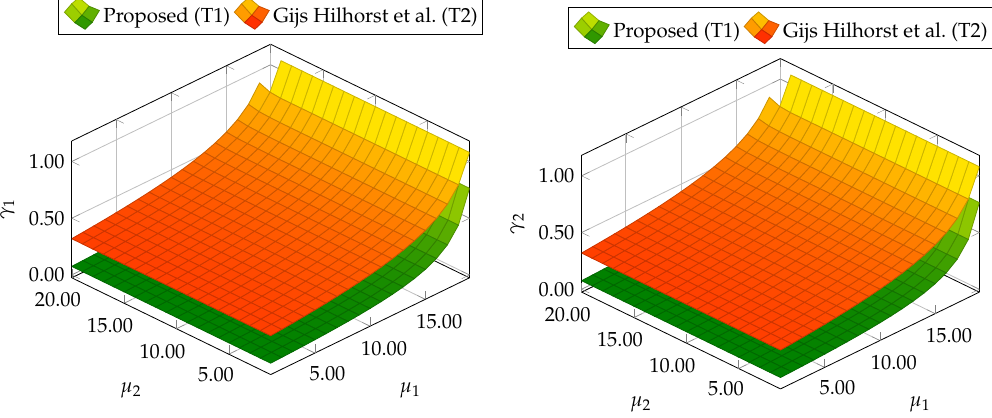
( z ) G e ∞ < µ 1 , f w 1 (cid:107) (cid:107)